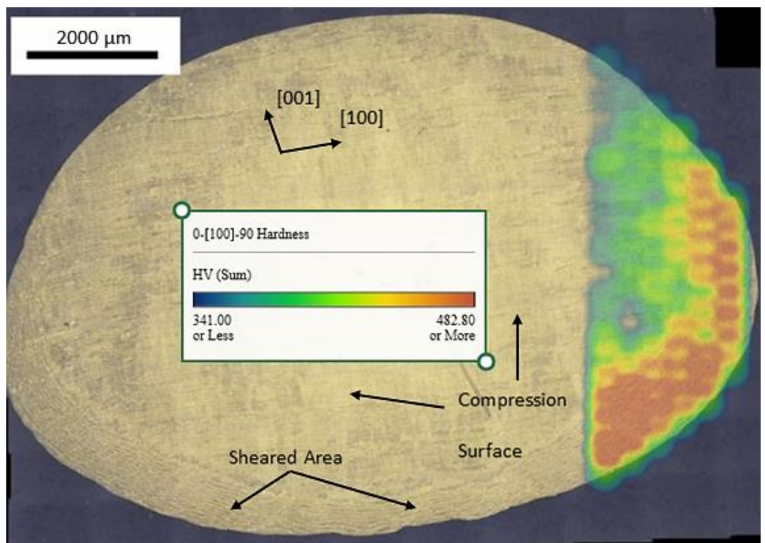
Figure 5. Hardness map of the 0 ◦ –[100]–90 ◦ specimen after